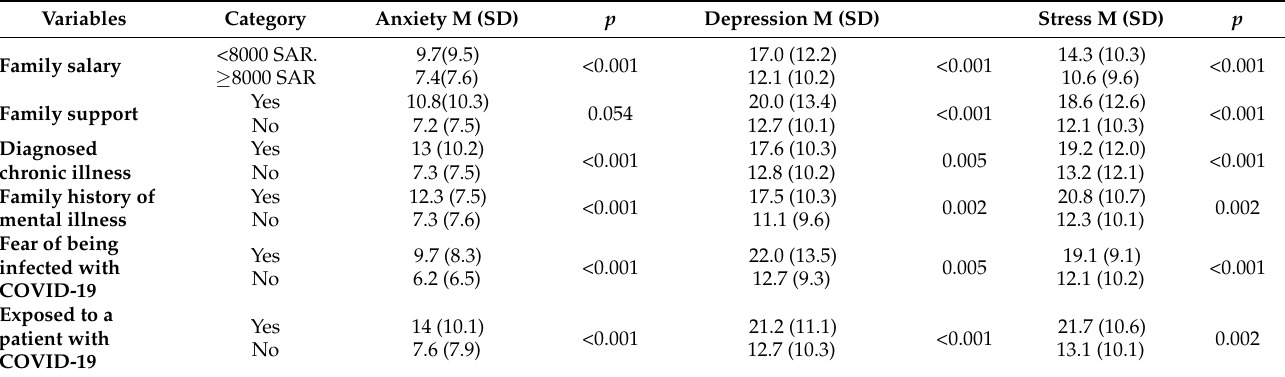
Table 3. Predictors of ADS among nursing college students ( N =